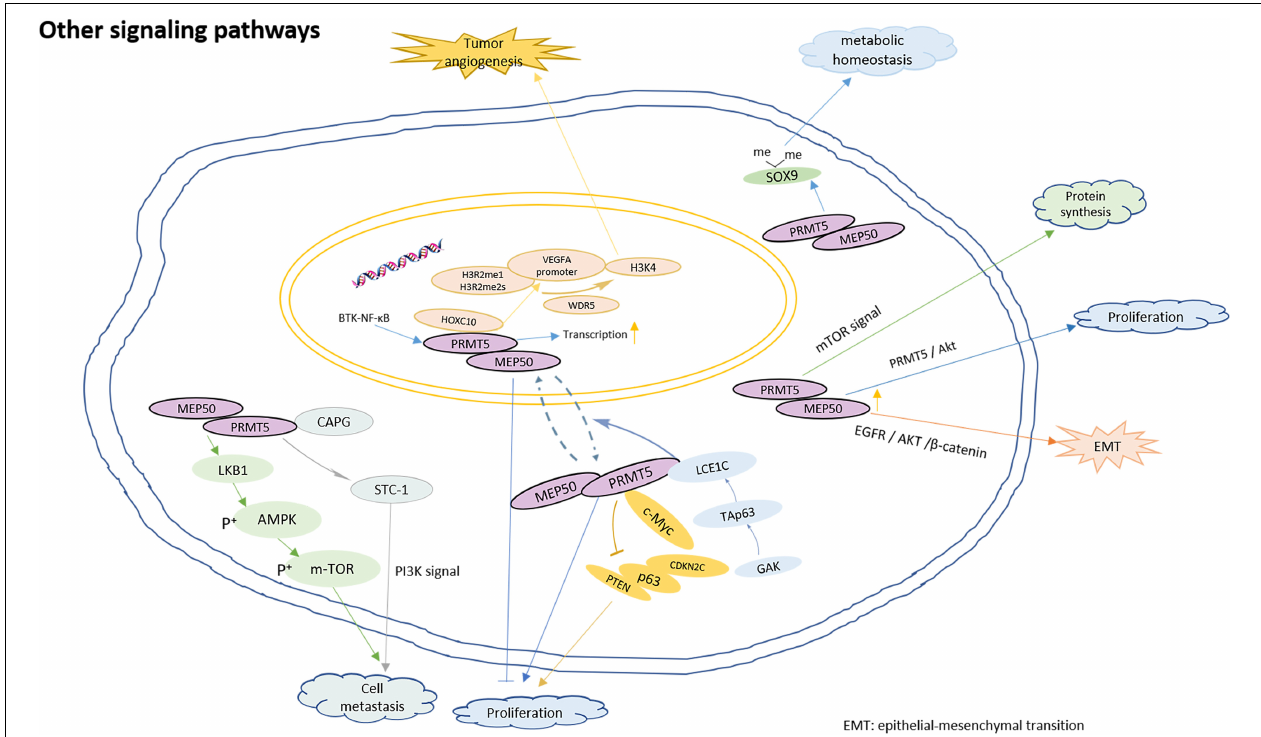
FIGURE 5 | The model for PRMT5 roles in regulation of other biological functions. PRMT5 interacts with LCE1C, and LCE1C promotes the cytoplasmic retention of PRMT5 or the transport of PRMT5 from nucleus to cytoplasm through direct interaction, thereby preventing cell proliferation; The direct binding of PRMT5 and c-Myc transcriptionally inhibits the expression PTEN, p63, CDKN2C, and so on, thus promoting the proliferation of gastric cancer cells; The depletion of PRMT5 activates mTOR signaling and increase protein synthesis in hematopoietic stem cells; PRMT5 interacts directly with HOXC10, promoting the enrichment of H3R2me1 and H3R2me2s on the VEGFA promoter, and recruiting WDR5 for subsequent methylation of H3K4 on the VEGFA promoter, which eventually leads to the transcription of VEGFA and promotes angiogenesis in glioma; PRMT5 promotes the metastasis of laryngeal carcinoma by activating Wnt4/ β – catenin signaling pathway; PRMT5 directly binds to CAPG, and CAPG regulate STC-1 transcription by competing with PRMT5 to enhance breast cancer metastasis; Knocking down PRMT5 could inhibit tumor growth and lung metastasis by up-regulating the expression of LKB1 and p-AMPK, and down-regulating the expression of p-mTOR; overexpressed PRMT5 promotes EMT by activating EGFR/AKT/ β -catenin signaling; PRMT5 could improve SOX9 stability by dimethylating the protein, which contributes to maintain the matrix metabolic homeostasis of the chondrocytes.